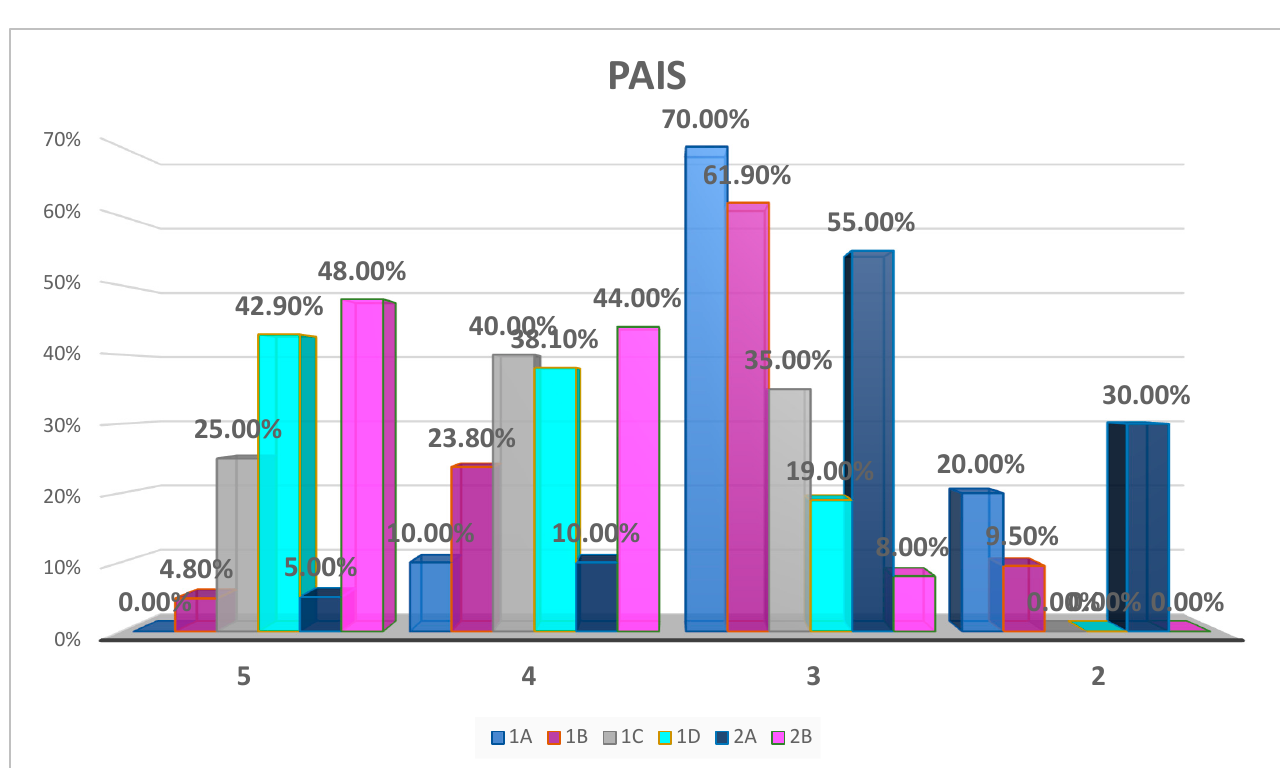
Figure 6. Comparative clinical efficacy of products in the main group and the comparison group according to the PAIS (Patient Aesthetic Improvement Scale) (satisfaction according to patients), where 2—no change; 3—minimal improvement; 4—good improvement; 5—optimal